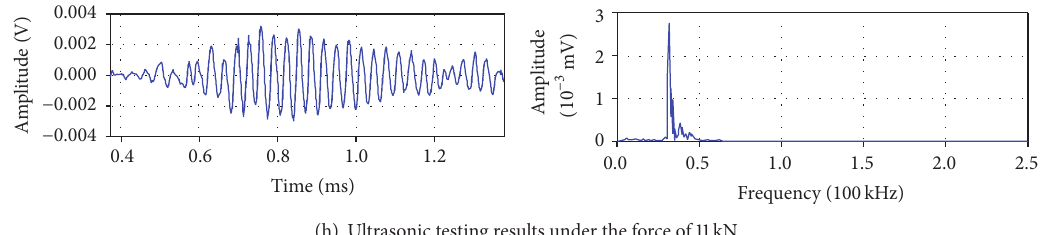
Figure 6: Experimental results for coal samples under cyclic